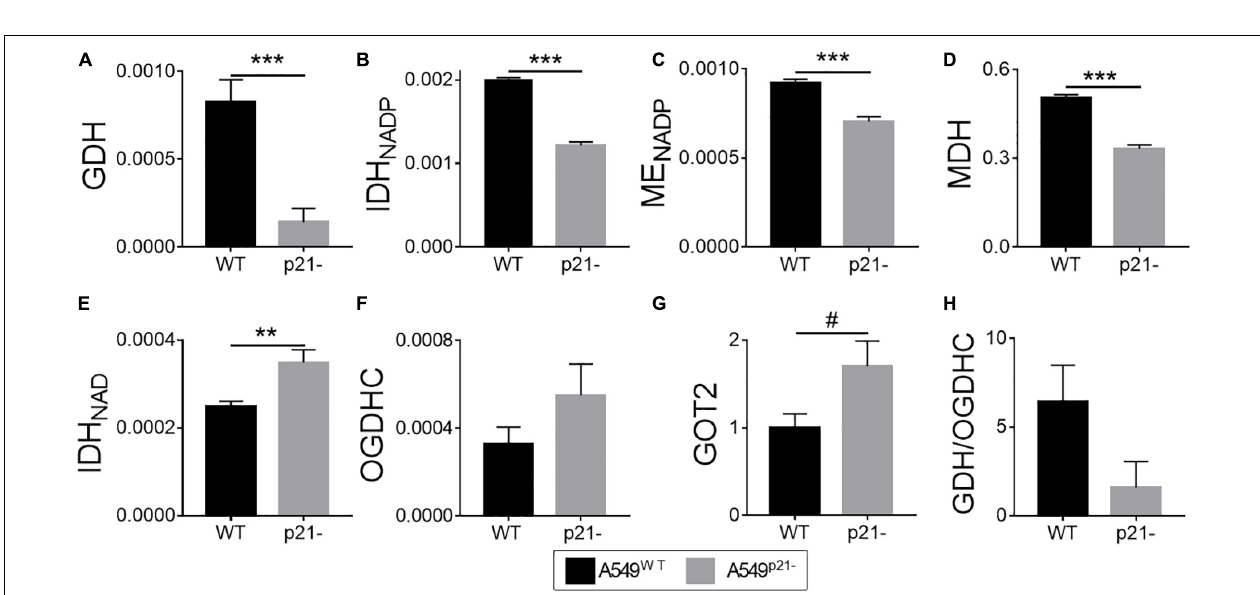
FIGURE 2 | Effect of p21 knockdown in A549 cells on the levels of the TCA cycle and affiliated enzymes. (A–F) Activities of the enzymes indicated on Y axes are shown as µ mol · min − 1 · mg − 1 ; (G) protein level of the mitochondrial aspartate aminotransferase (GOT2), arbitrary units; (H) ratio of activities of GDH to total OGDHC, assessing the maximal glutamate degradation in the TCA cycle. The data are obtained from three independent cell cultures. Values are presented as mean ± SEM. Statistical significance of the differences is determined according to the Mann-Whitney test. Different p -values are shown by asterisks and mesh-sign as described in Materials and Methods under Statistical Analysis